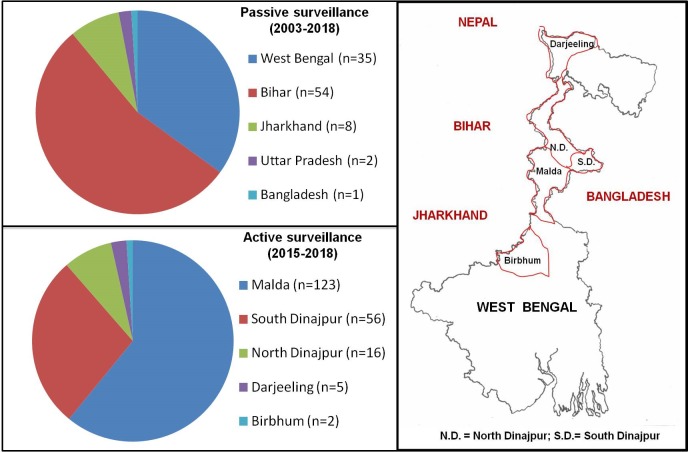
Geographical pie distribution of PKDL cases recruited through passive and active surveillance.A map of West Bengal highlighting the VL-endemic districts from where patients were recruited during active surveillance.